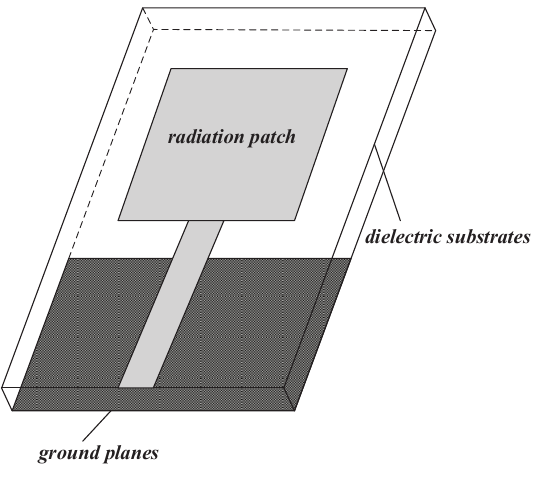
Figure 2. Structure chart of a printed monopole